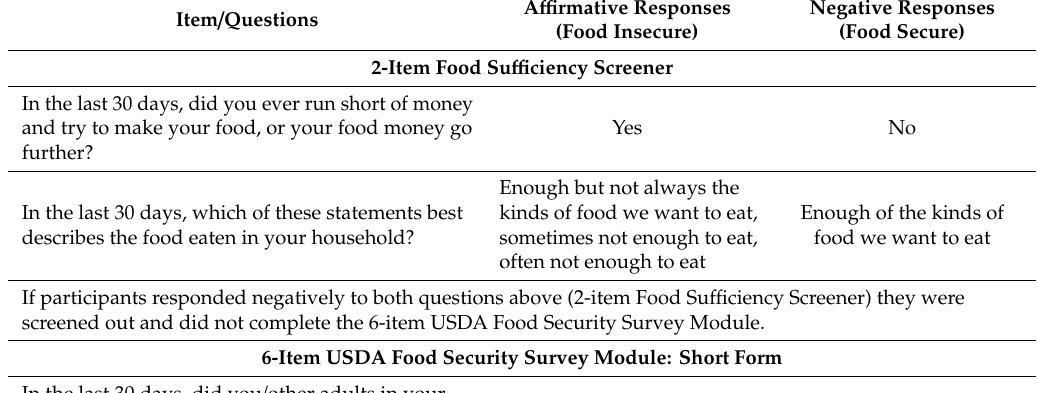
Table 1. Food security survey questions and response